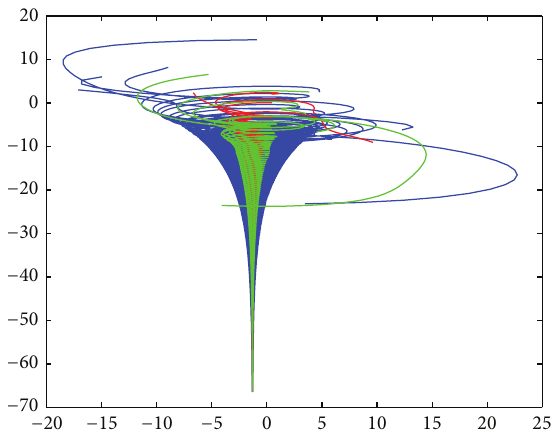
Figure 5: Trajectories of 20 agents on the same phase plane. Trajectories of 𝑆 1 ,...,𝑆 10 colored blue, 𝑆 11 ,...,𝑆 15 colored red, and ,...,𝑆 𝑆 16 20 colored